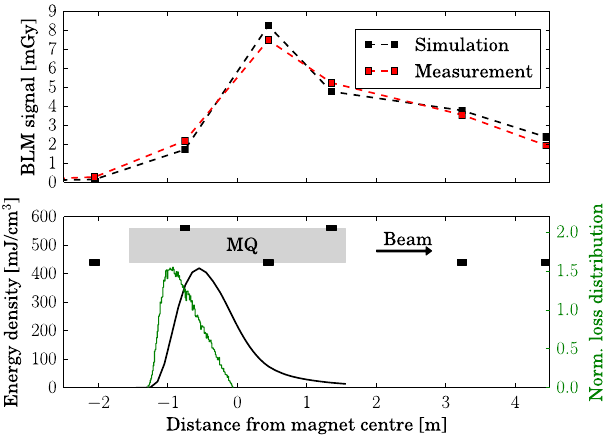
FIG. 14. Up: Detail of the comparison between the BLM signal, accumulated during the intermediate-duration orbit bump quench test, and the simulated signal from FLUKA. Down: FLUKA simulated peak energy density deposited in the coils (black) and MAD-X histogram of protons lost on the beam-screen (green), normalized to the total number of simulated lost particles. The gray box indicates the magnet, black boxes indicate the locations of